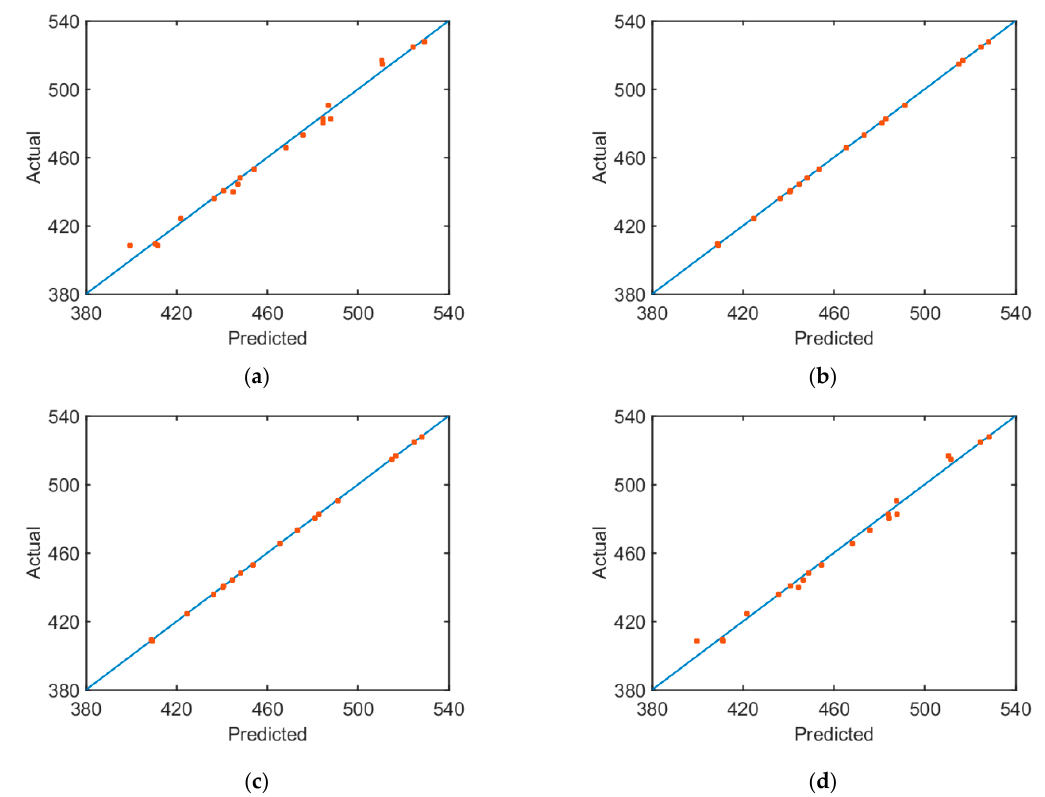
Figure 10. The diagram of the relationship between actual and predicted values of first-order inherent frequencies. ( a ) First-order RMS; ( b ) second-order RMS; ( c ) third-order RMS; ( d ) RBF neural network.